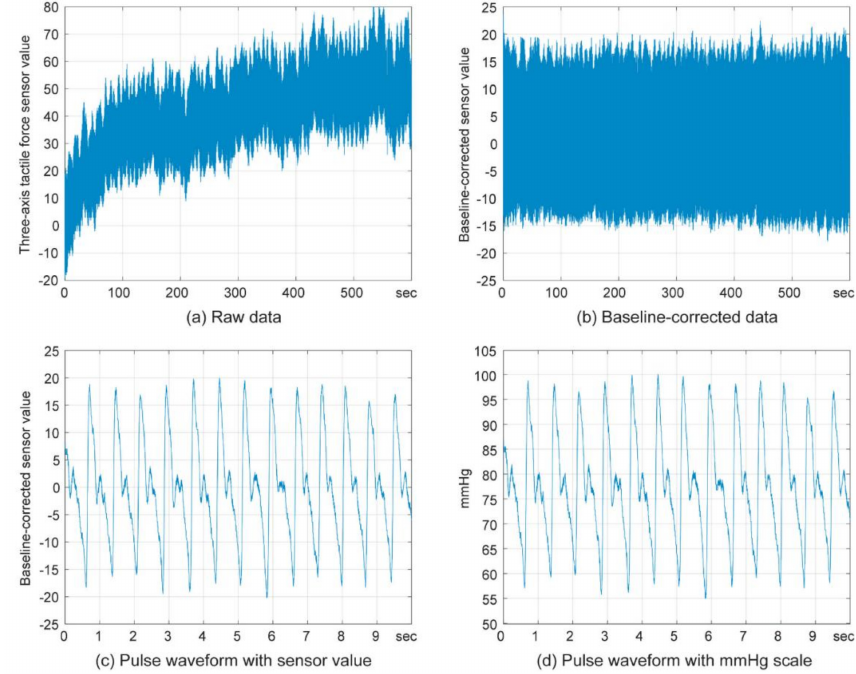
Figure 2. ( a ) Raw data from three-axis tactile force sensor in short-term experiment; and ( b ) the result of baseline correction with the Savitzky–Golay algorithm; ( c ) Recorded pulse waveform with original sensor scale and ( d ) with mmHg scale calibrated by the oscillometric